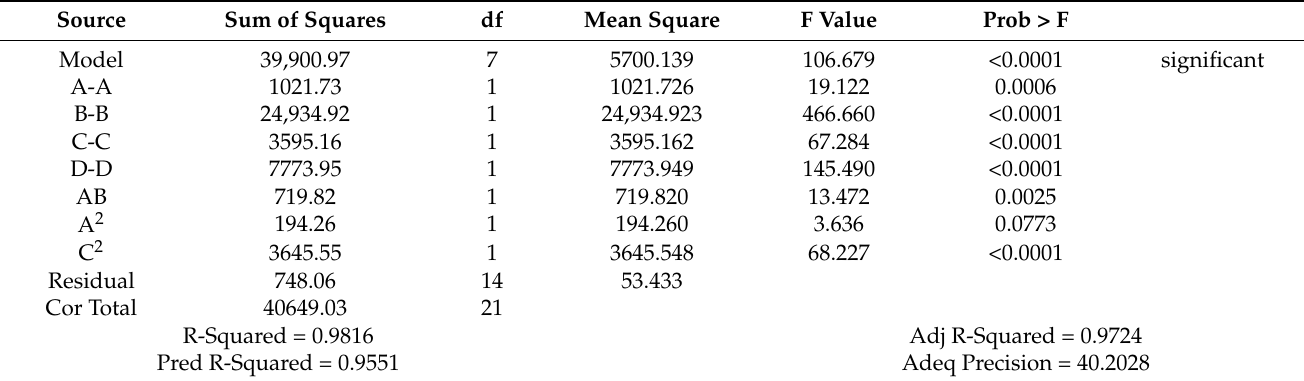
Table A4. ANOVA analysis for the regression model of electrode tip temperature.